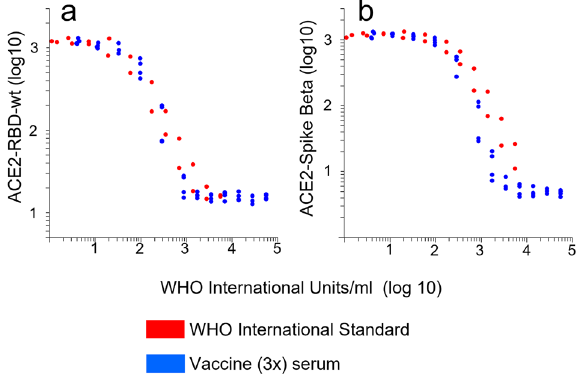
Fig. 4 Calibration of RBD-ACE2 interaction assays. The dot plots show effects of serial dilutions of the WHO-international standard (NIBSC code: 20/136, red dots) or a post-vaccine serum (3x P fi zer/ BionTech) on ACE2-binding to RBDwt and spike from the beta- variant. a , b The values on the x -axis correspond to WHO international units for neutralizing effects of the standard and WHO binding antibody units per ml for the post-vaccine serum measured by Roche Elecsys SARS-CoV-2 S. The units are equivalent for sera diluted 1:100. The results were cumulated from two experiments. The lowest dilution for the WHO-standard and the post-vaccine serum was 1:20 and 1:100, respectively. Source data are provided as a Source Data fi